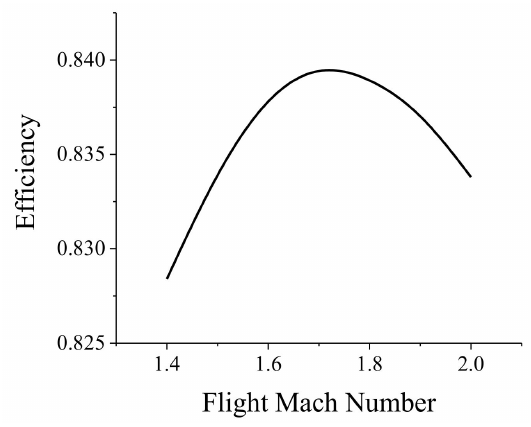
Figure 9. AFS Efficiency vs. Flight Mach